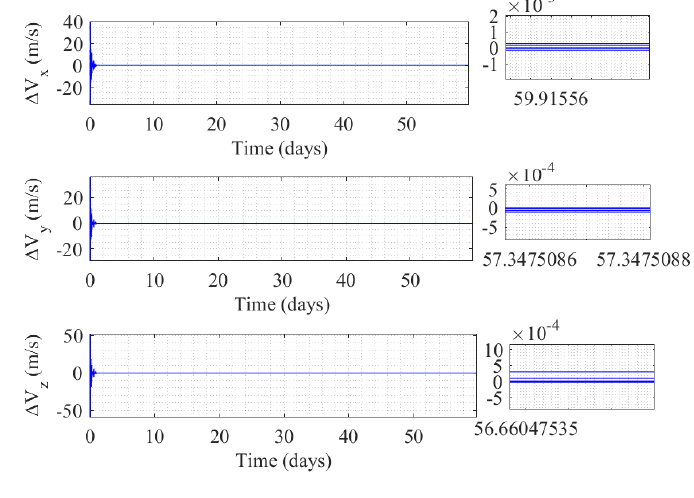
Figure 18. Control effects of coplanar satellites in the geocentric inertial